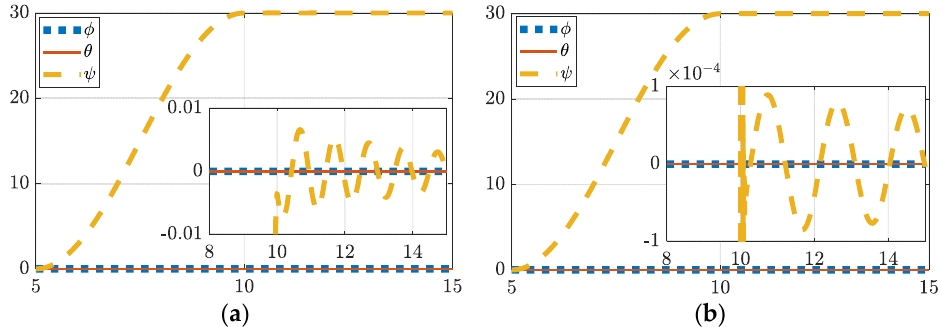
Figure 4. ( a ) One hundred degree yaw feedforward plus feedback (FFD + FB) control; ( b ) one hundred degree yaw with hybrid deterministic artificial intelligence (DAI) control. Both figures include display of tracking errors in the zoomed-inset graphic. Notice the ordinate scale, respectively of insets in subfigure ( a , b ) to reveal the relative comparison.